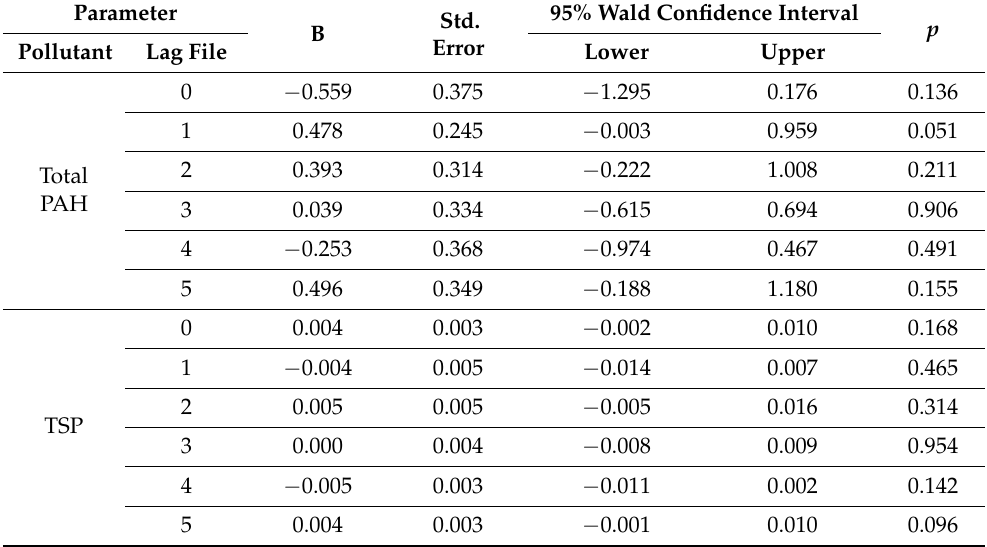
Table 2. Relationships between PAHs and nasal symptoms.